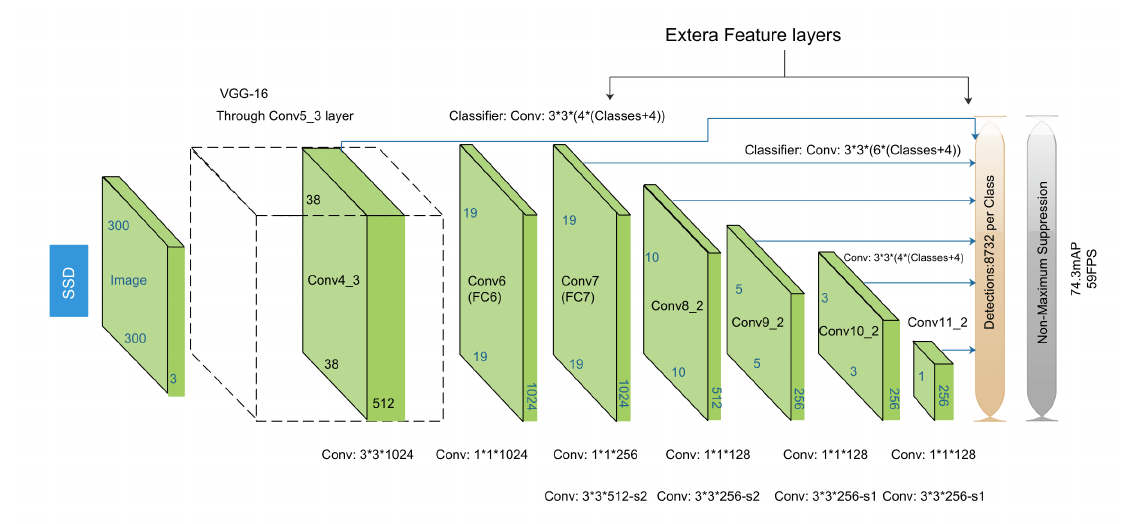
Figure 4. Single Shot Multi-Box Detector (SSD) architecture [47].